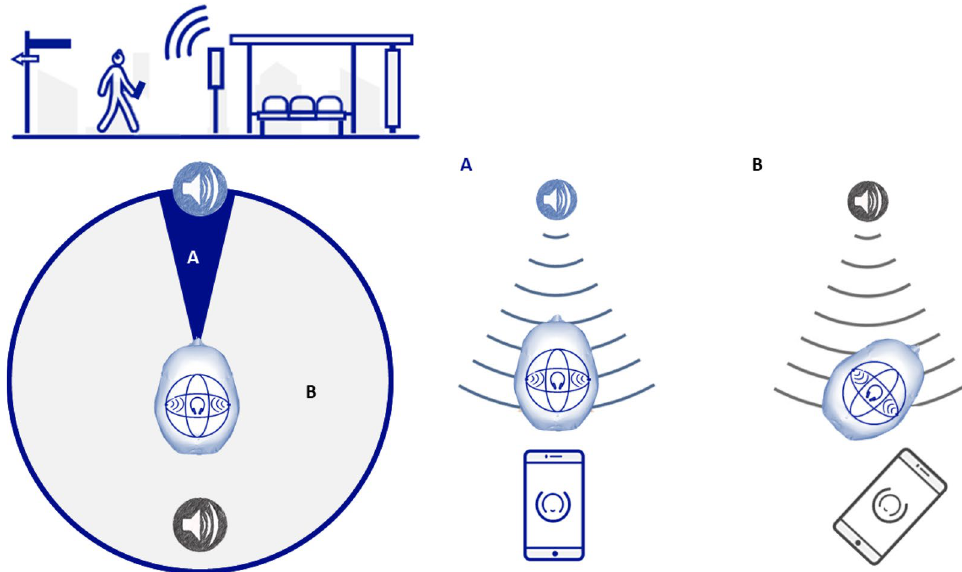
Figure 1. Implementation of the Beacon. The participant receives spatial audio information as coming from the beacon source. To amplify the information of directionality, we further implement two types of sounds depending on whether the participant is pointing directly at the beacon ( A ) or it is walking in another direction ( B ). This small design decision guides participants into finding the beacon